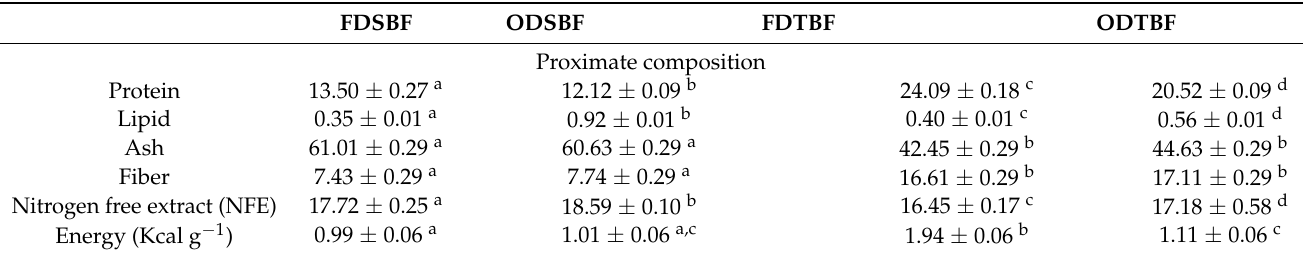
Data are means ± SE, n = 3. Treatments: freeze-dried shrimp biofloc (FDSBF), oven-dried shrimp biofloc (ODSBF), freeze-dried tilapia biofloc (FDTBF), and oven-dried tilapia biofloc (ODTBF). Means with different superscripts in rows are significantly different ( p <